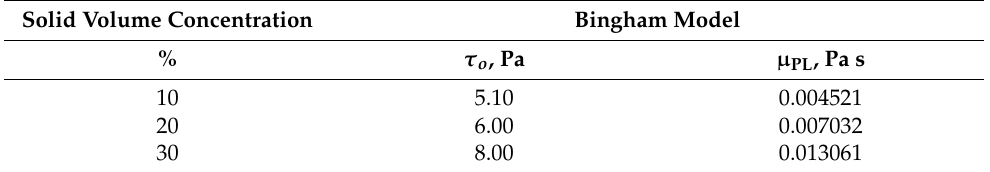
Figure 3. ( a ) Comparison of assumed relative viscosity with experimental data of fine dispersive slurry for the Bingham model (Shook and Roco [6]; Slatter [82]). ( b ) Comparison of assumed relative yield stress with experimental data of fine dispersive slurry for the Bingham model (Shook and Roco [6]; Slatter [82]). Table 1. Parameters of the fine dispersive slurry for the Bingham model.